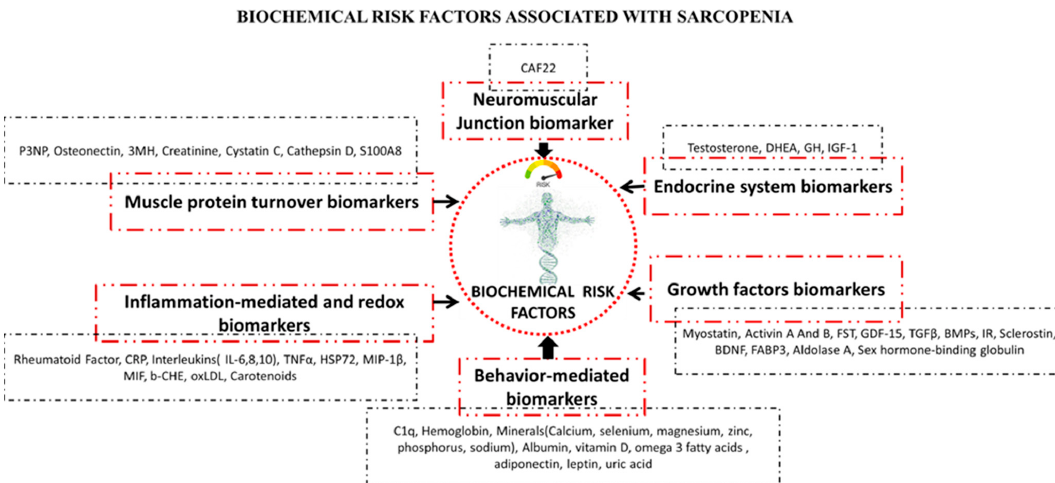
Figure 2. Biochemical risk factors are contributed by different pathways. Biomarkers associated with people with sarcopenia based on different pathways include neuromuscular junction biomarkers (CAF22); endocrine system biomarkers (T, DHEA, GH, IGF1); growth factors biomarkers (myostatin activin A and B, FST, GDF-15, TGF β , BMPs, IR, sclerostin, BDNF, FABP3, aldolase A, sex hormone-binding globulin); behavioral-mediated biomarkers (C1q, hemoglobin, minerals (calcium, selenium, magnesium, zinc, phosphorus, sodium), albumin, vitamin D, omega 3 fatty acids, adiponectin, leptin, uric acid); inflammation-mediated and redox biomarkers (rheumatoid factor, CRP, interleukins (IL-6,8,10), TNF α , HSP72, MIP-1 β , MIF, b-CHE, oxLDL, carotenoids); muscle protein turnover biomarkers (P3NP, osteonectin, 3MH, creatinine, cystatin C, cathepsin D, S100A8). CAF22, C-terminal agrin fragments 22; T, testosterone; DHEA, dehydroepiandrosterone; GH, growth hormone; IGF1, insulin-like growth factor-1; FST, follistatin; GDF-15, growth differentiation factor 15; TGF β , transforming growth factor beta; BMPs, bone morphogenic proteins; IR, irisin; BDNF, brain-derived neurotrophic factor; FABP3, fatty acid binding protein 3; C1q, complement component 1q; TNF α , tumor necrosis factor α ; HSP72, heat shock 70 kDa protein 1; MIP-1 β , macrophage inflammatory protein 1 β ; MIF, macrophage migration inhibitory factor; b-CHE, butyryl-cholinesterase; oxLDL, oxidized low-density lipoprotein; P3NP, N-terminal peptide; 3MH,